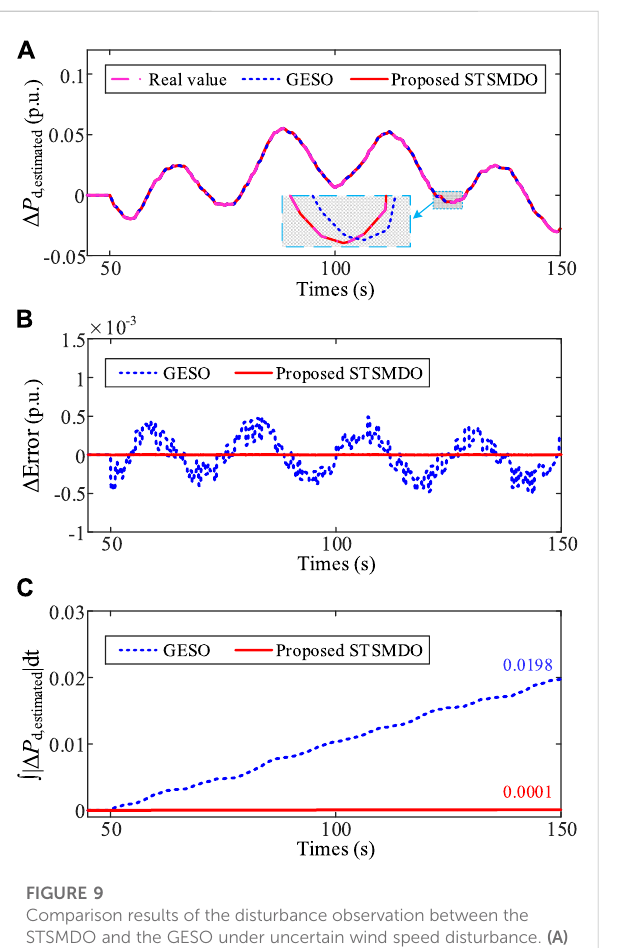
FIGURE 10 Comparisonresultsofthesystemfrequency fl uctuationbetween the SMFC and the OFC under uncertain wind speed disturbance. (A) System frequency fl uctuation. (B) Total frequency fl uctuation level , | Δ f |dt. (C) Wind power